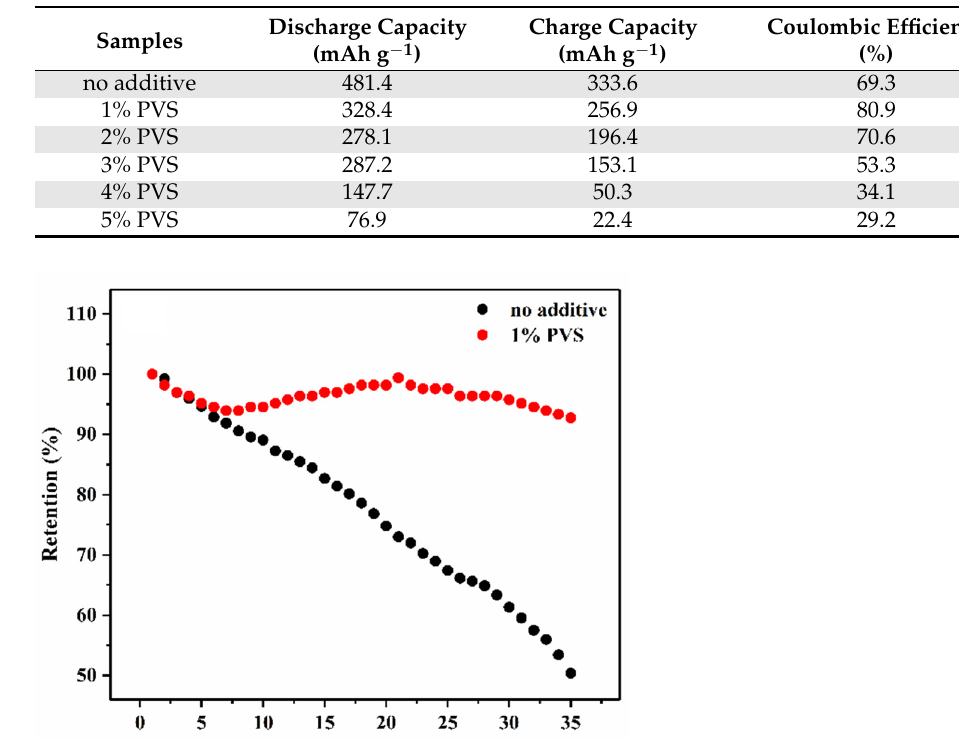
Table 1. The charge capacity, discharge capacity, and CE of the Li/graphite half-cells containing various doses of PVS.